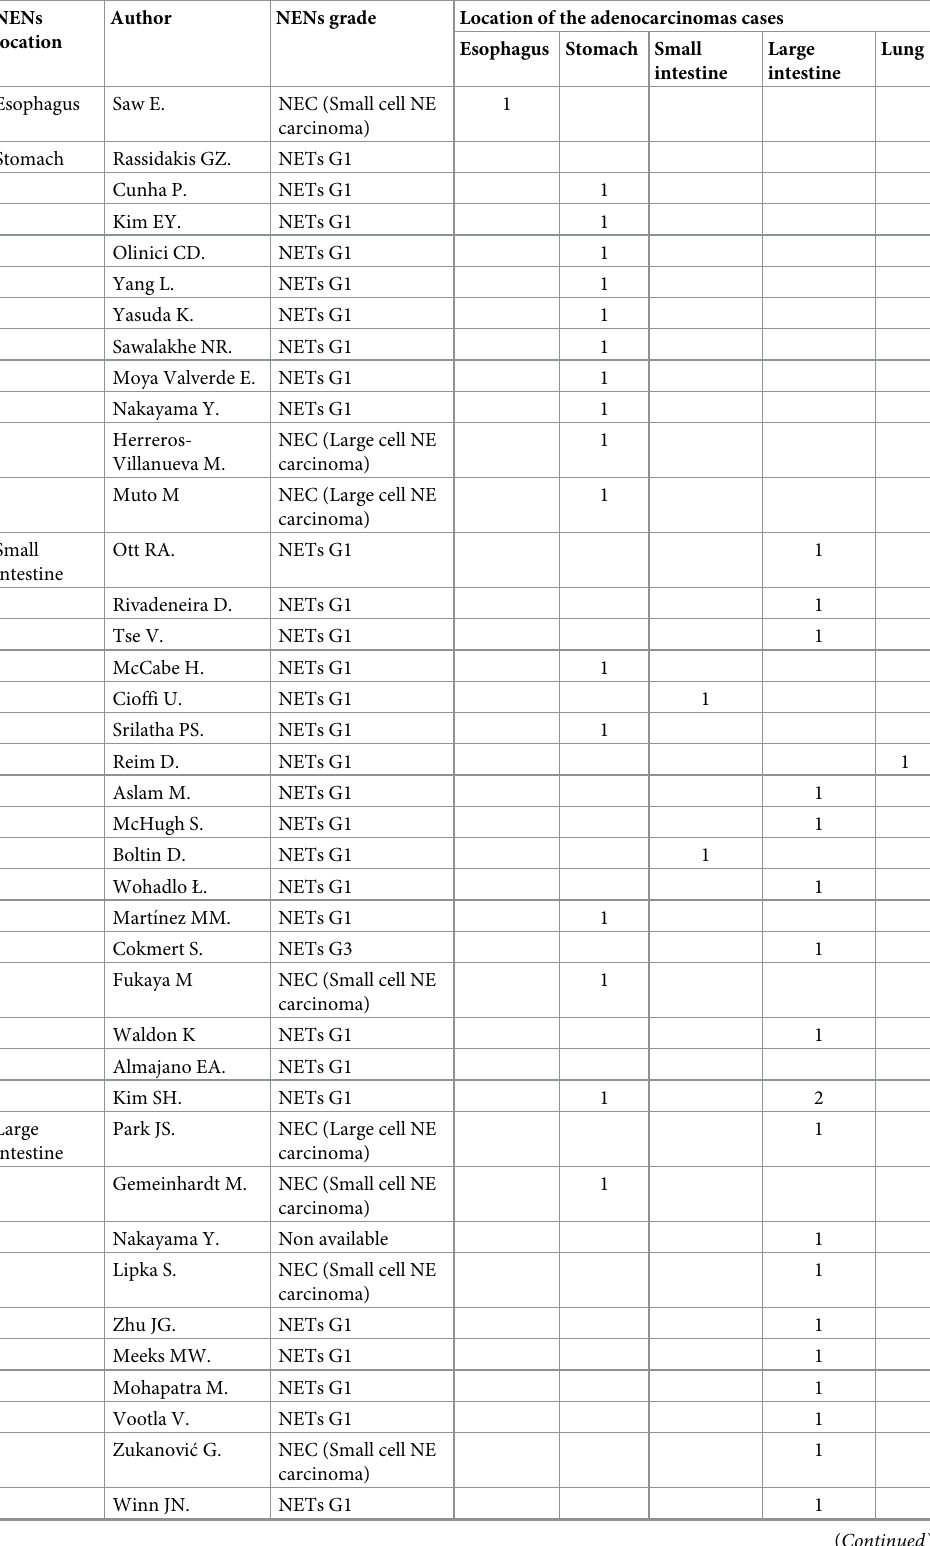
Table 3. Characteristics of the adenocarcinomas